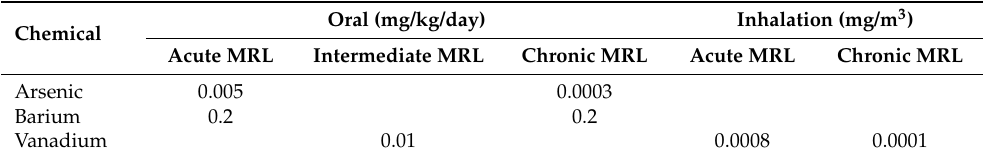
Table 6. Non-cancer minimum risk levels (MRLs) for acute and chronic toxicity in units of mg/kg/day. MRLs were not available for dermal routes of